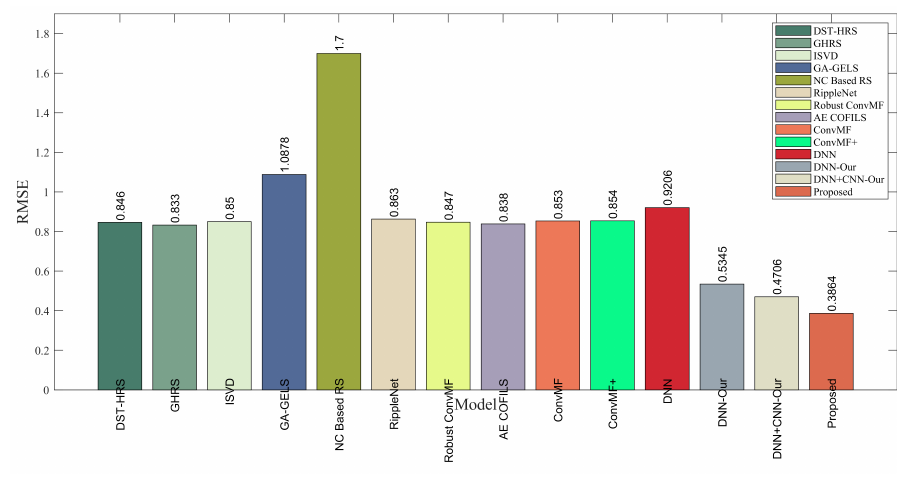
Figure 14. Performance comparison chart with some major and recent